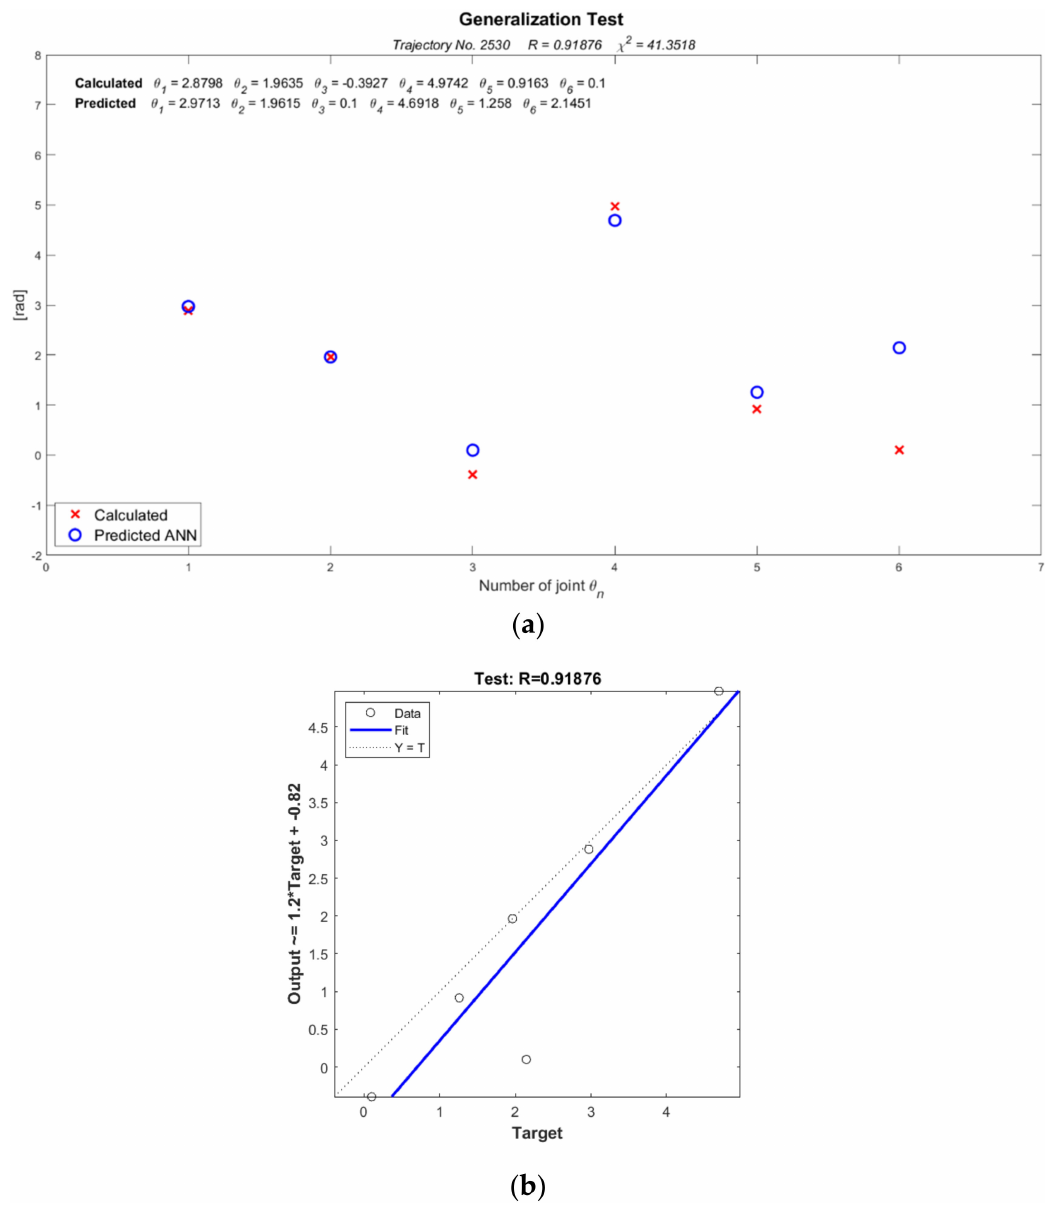
Figure 9. Trajectory of the manipulator with the worst prediction and correlation test: ( a ) worst predicted values; ( b ) correlation